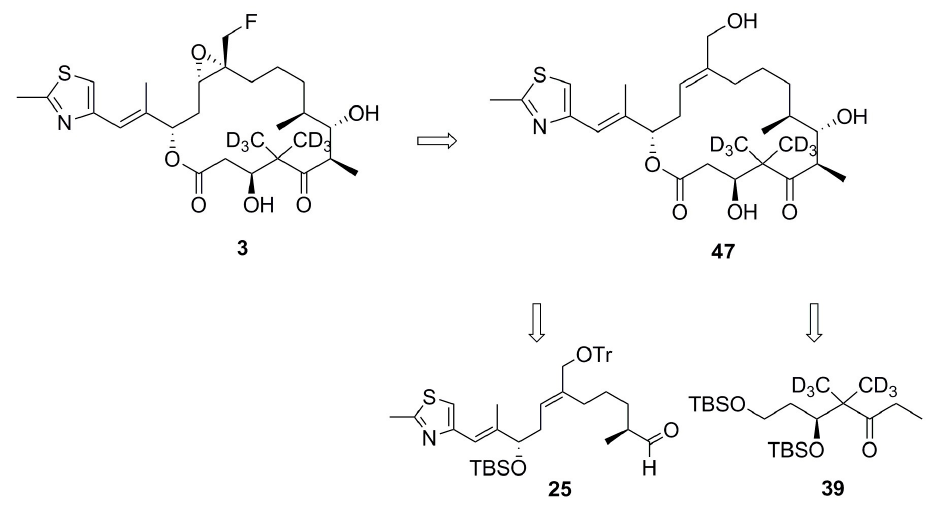
Figure 2. Retrosynthesis of analog 3 .